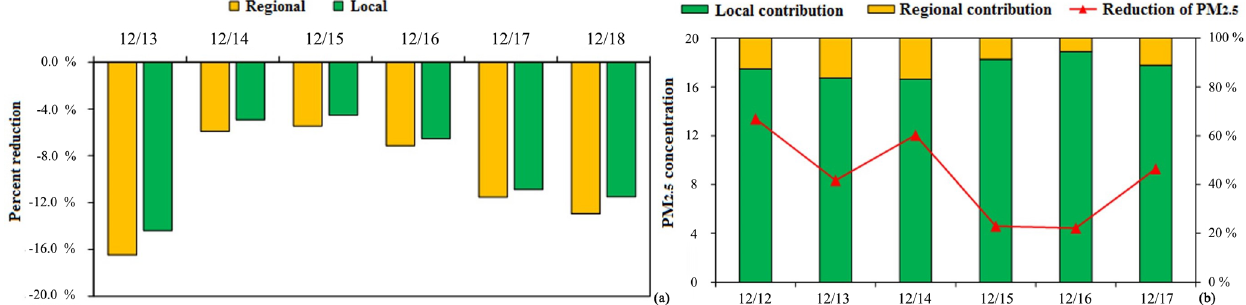
Figure 16. Percentage reduction in daily average PM 2 . 5 concentrations from 13 to 18 December after implementation of the control measures across the region and in Jiaxing (a) and contribution of local and regional emission reductions in Jiaxing, and the resulting improvement of daily average PM 2 . 5 concentrations in Jiaxing (b) . Table 5. Control measure optimization scenario